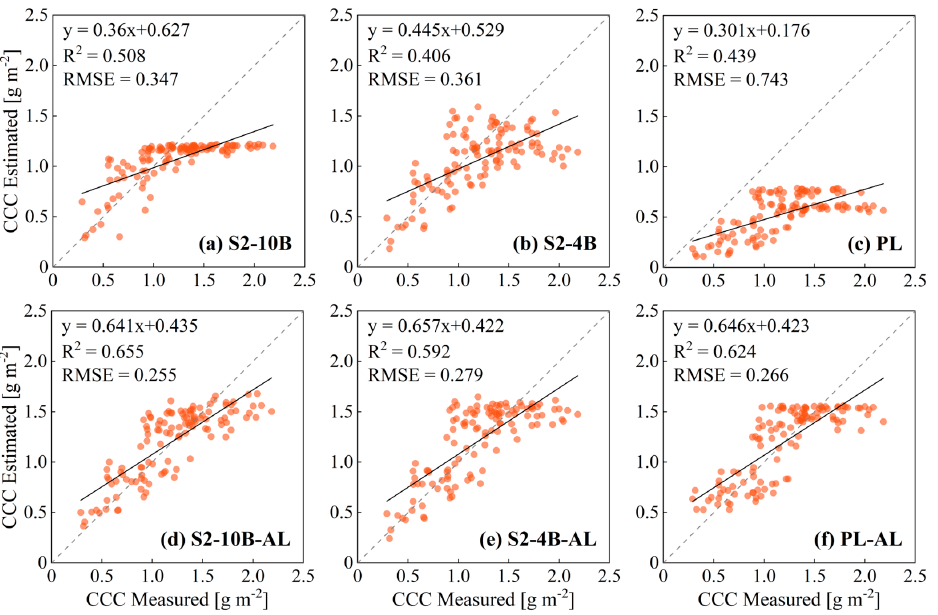
Figure 3. Relationship between the measured and retrieved CCCs in Dajianchang town using the hybrid model and ( a ) Sentinel-2 imagery with 10 bands, ( b ) Sentinel-2 imagery with 4 bands, and ( c ) Planet imagery without the AL strategy; ( d – f ) the results using the hybrid model and three types of images with the AL strategy, respectively.